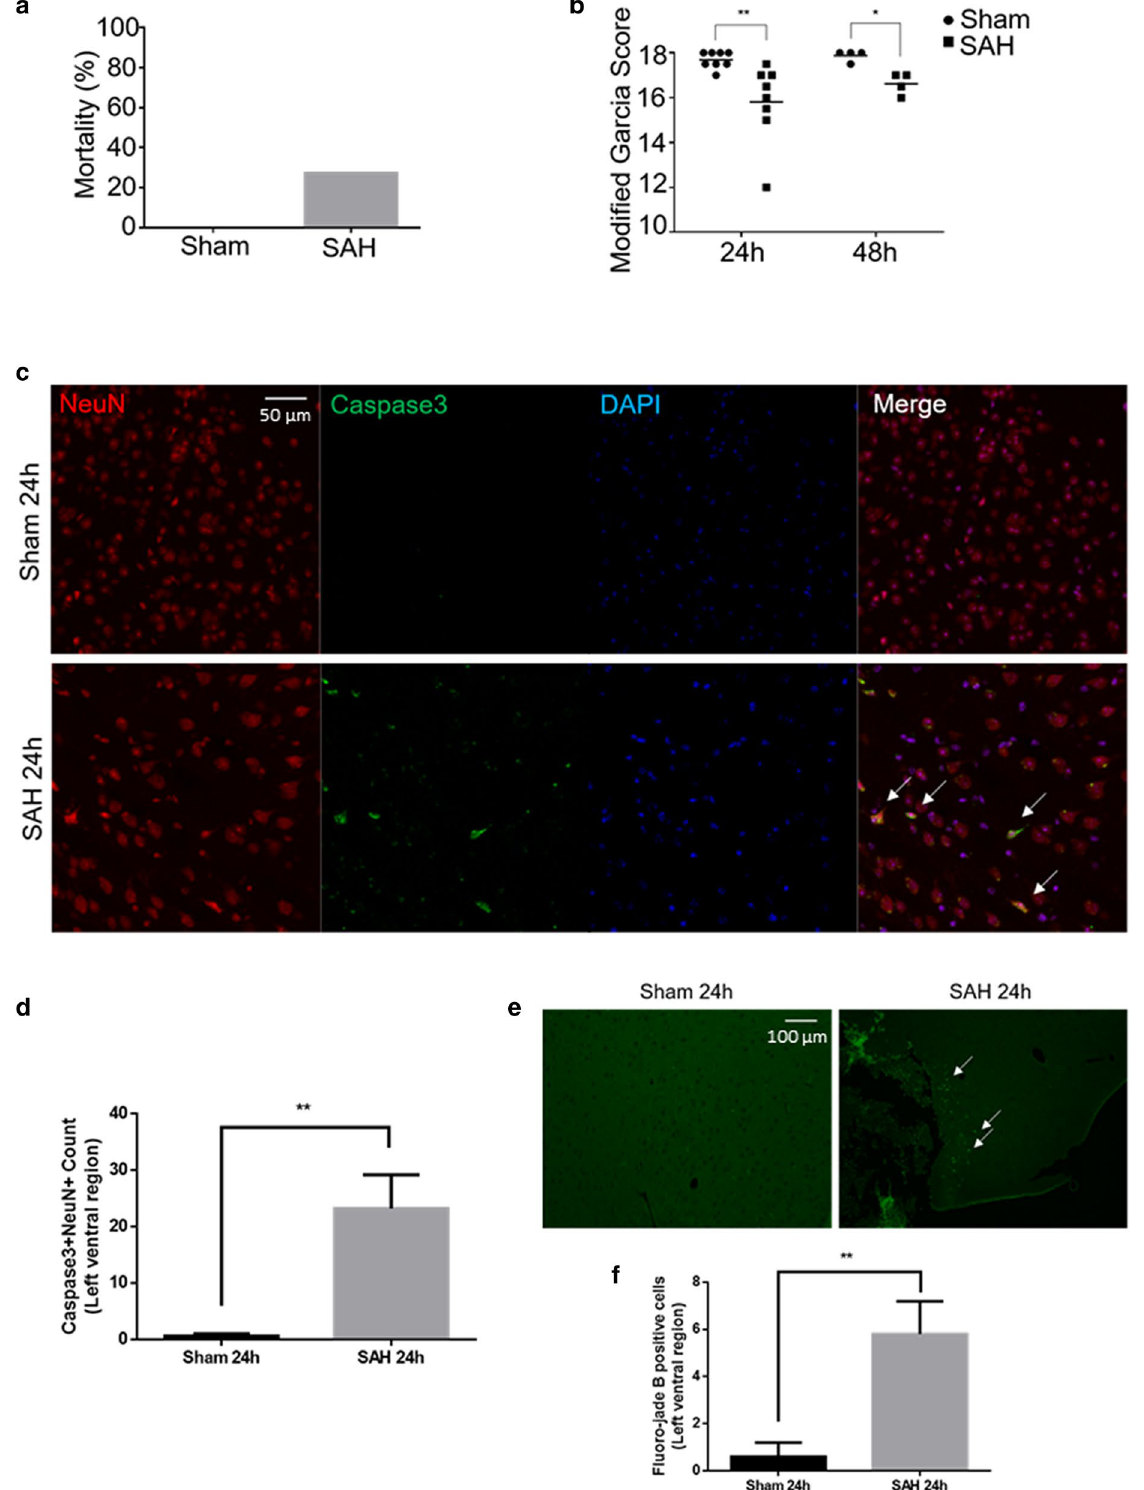
Figure 1. Experimental SAH neurobehavioural and histological assessments. ( a ) Mortality after SAH induction or sham procedure. ( b ) Modified Garcia Score at 24 h and 48 h after SAH induction or sham procedure (maximum normal score is 18). ( c ) Merged triple-stained immunofluorescent confocal microscopy of coronal brain slices 24 h after SAH induction or sham procedure (NeuN (neuronal marker) = red, Caspase-3 (apoptosis marker) = green, DAPI (nuclei marker) = blue). Arrows point to apoptotic neurons. ( d ) Semi-automated apoptotic neuronal count from left ventral region of coronal brain slices. ( e ) Fluorescent confocal microscopy with fluoro-jade B staining of coronal brain slices 24 h after SAH induction or sham procedure. Arrows point to degenerated neurons. ( f ) Semi-automated degenerated neuronal count from left ventral region of coronal brain slices. n = 8–11 per group for 1a-b. n = 4–5 per group for 1c-f. Data presented as means ± SEM (Standard error of the mean). Kruskal–Wallis test (Modified Garcia Score). t -test (Caspase 3, fluoro-jade B). * p < 0.05, ** p <